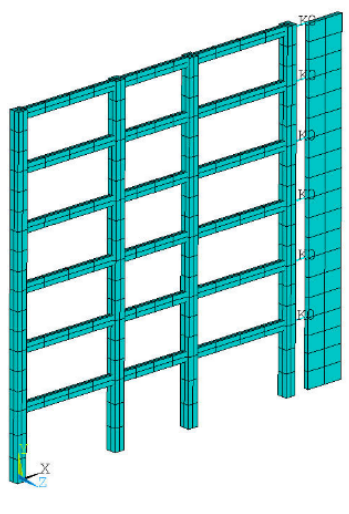
Figure 6. Plane finite element model.